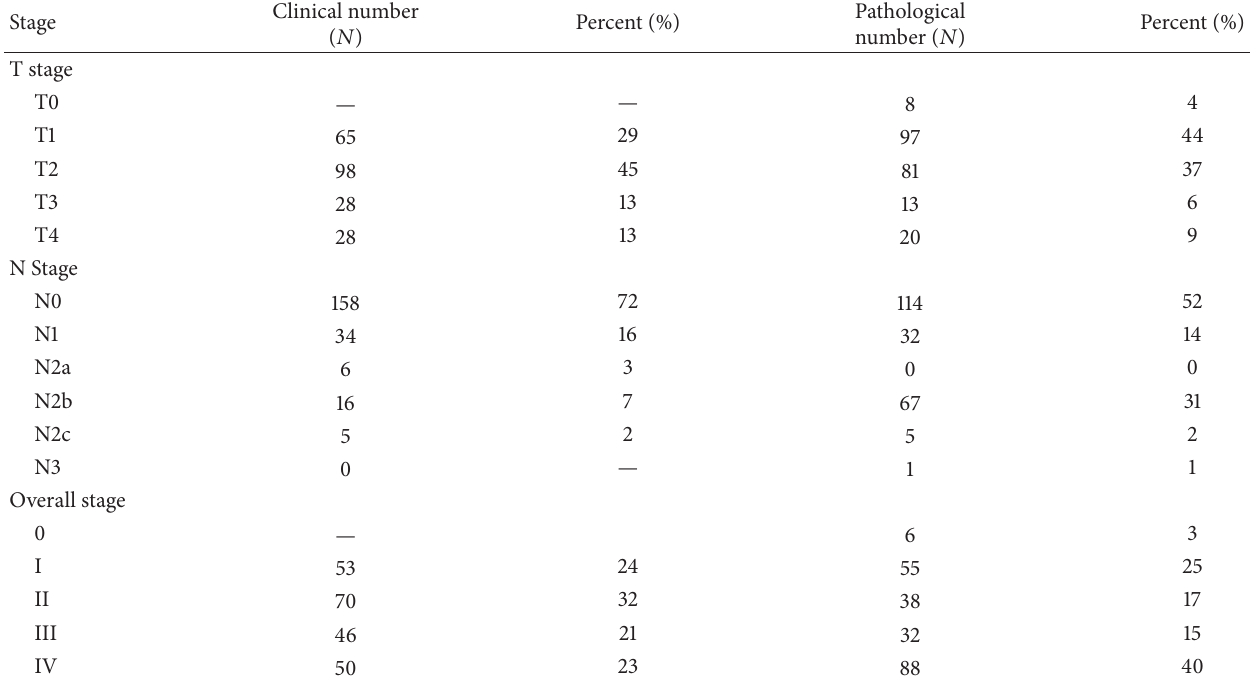
Table 2: Clinical and pathological staging of patients according to AJCC guidelines.